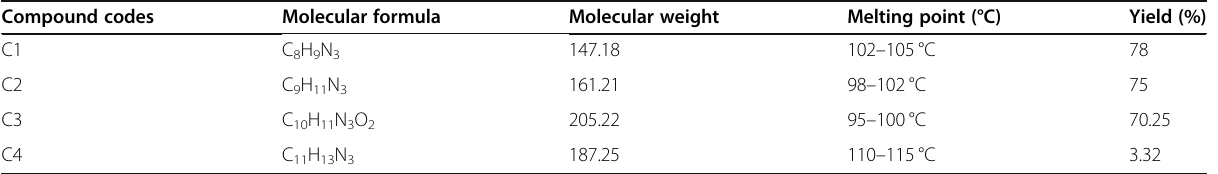
Table 1 Results of prediction of molecular descriptors Compound codes